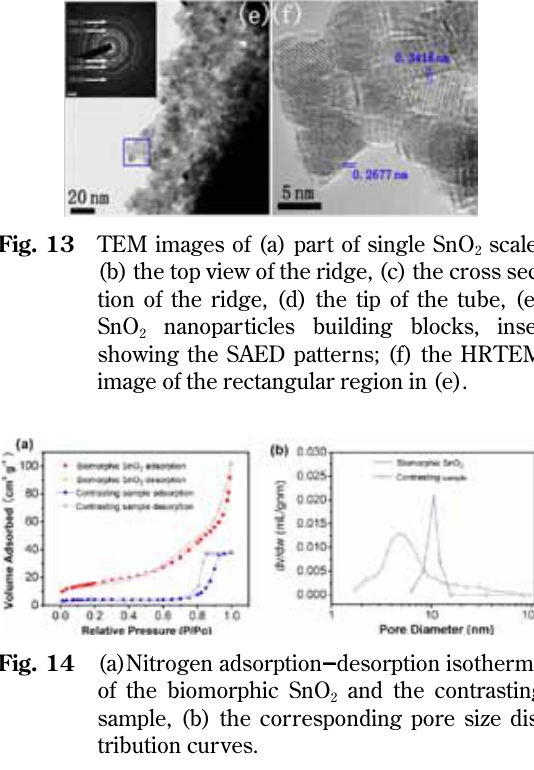
Fig. 14 (a)Nitrogen adsorption - desorption isotherms of the biomorphic SnO and the contrasting 2 sample, (b) the corresponding pore size dis- tribution